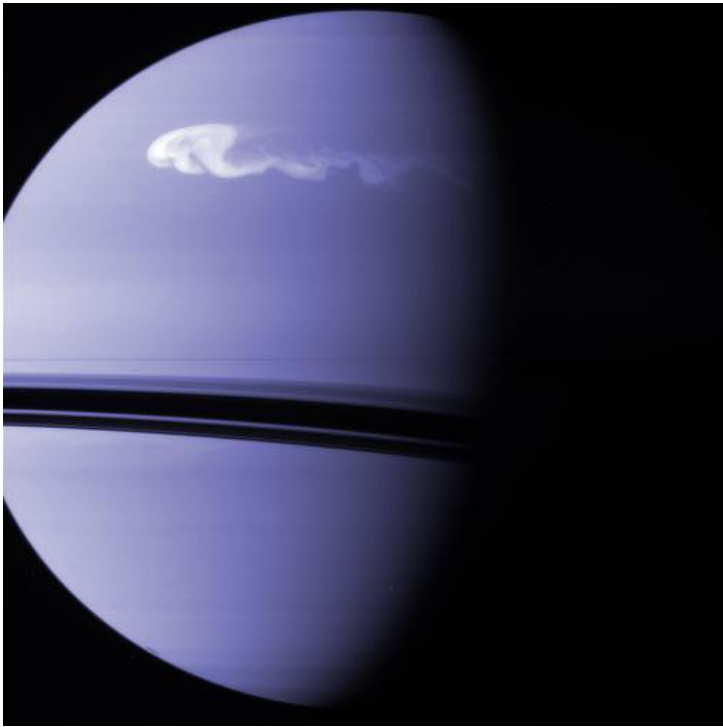
Figure 5. Cassini ISS image of the 2010 Saturn storm acquired on 24 December 2010. This image was downloaded from the PDS using the RMS OPUS tool (Section 3.1); the tint of this browse image is indicative of the wavelength range of the ISS filter through which the image was acquired (in this case, 429–492